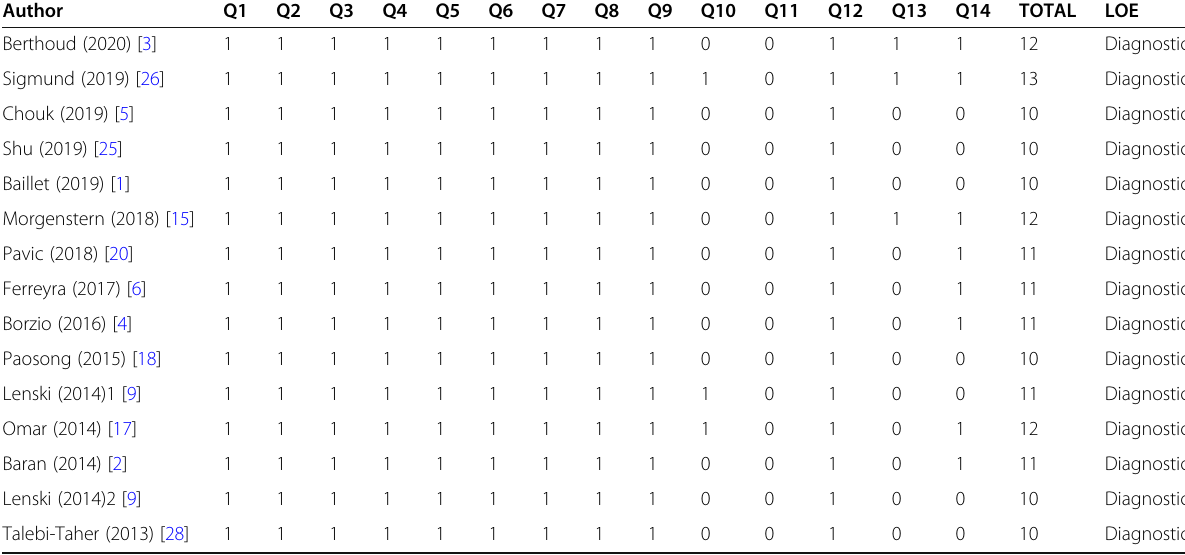
Table 3 QUADAS Tool Scoring and Level of Evidence